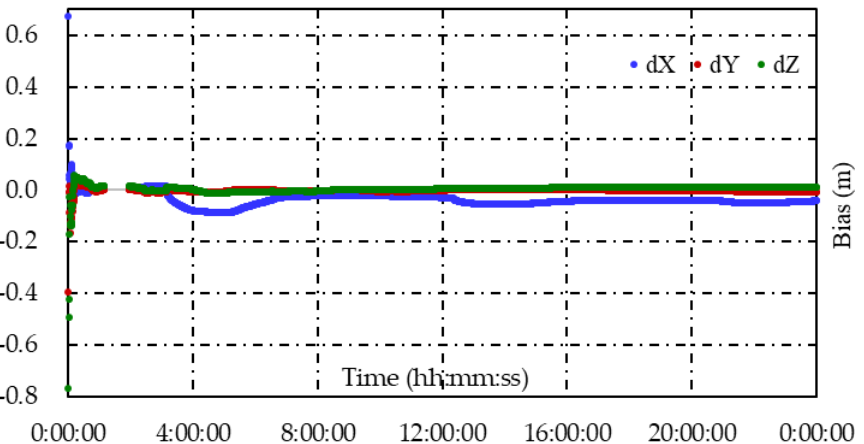
Figure 24. Coordinate biases from static PPP with method B with respect to Figure 7 (process noise of 100 m 2 is set for receiver clock error).